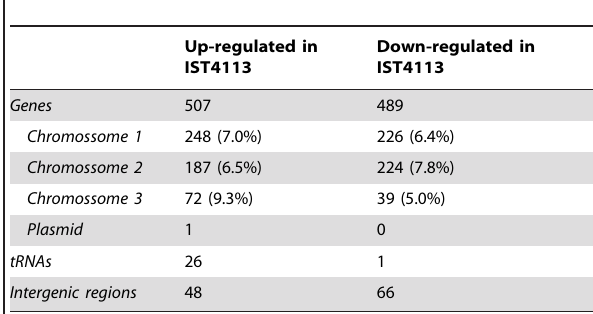
Table 1. Distribution of the genes differently transcribed (above or below a 1.5-fold) in IST439 and IST4113 through the B. cenocepacia J2315